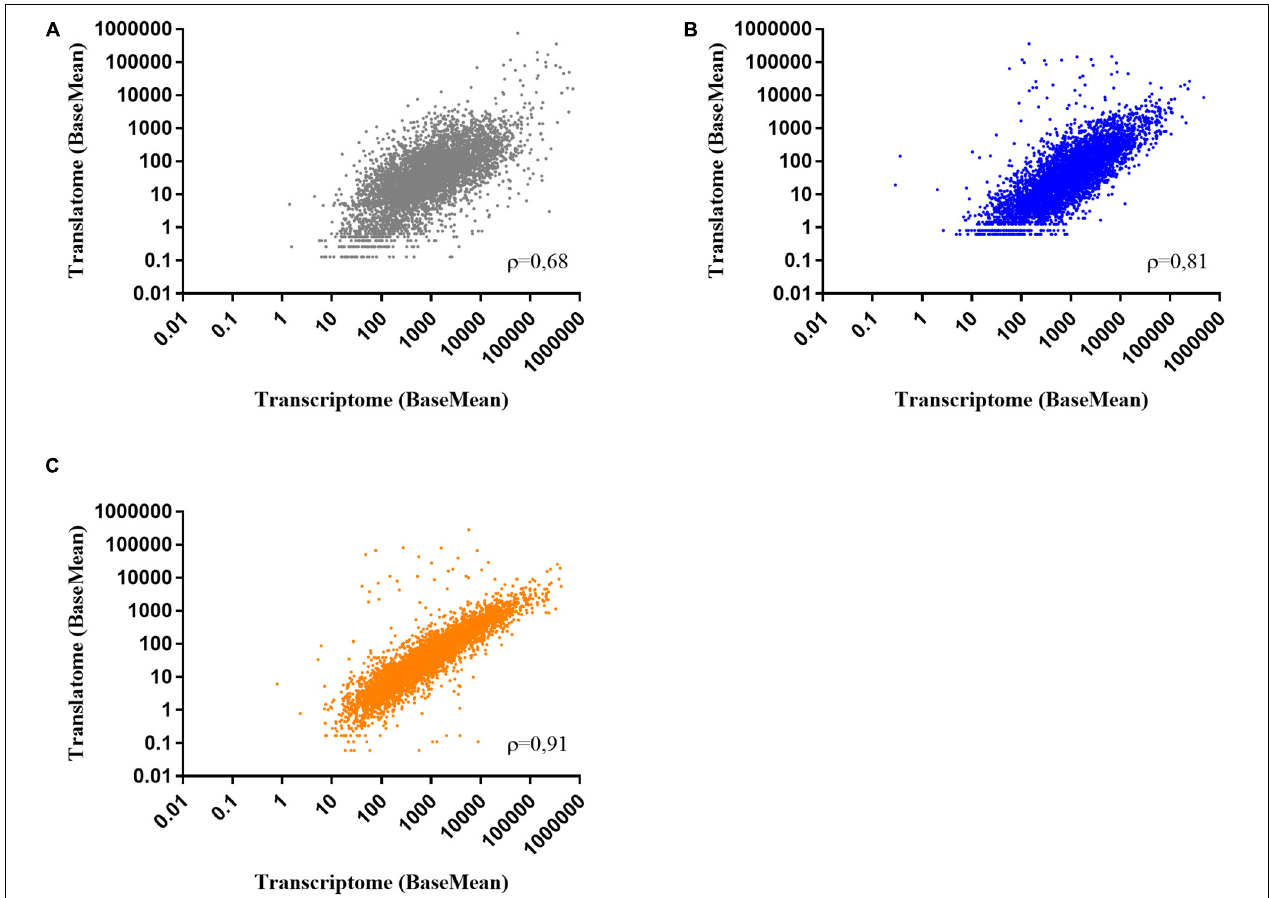
FIGURE 1 | Scatter plots showing the correlation between normalized RNA-seq and Ribo-seq sequencing reads (BaseMean) obtained from two biological replicates of (A) control, (B) colistin, and (C) tobramycin treated samples. ρ – Spearman correlation